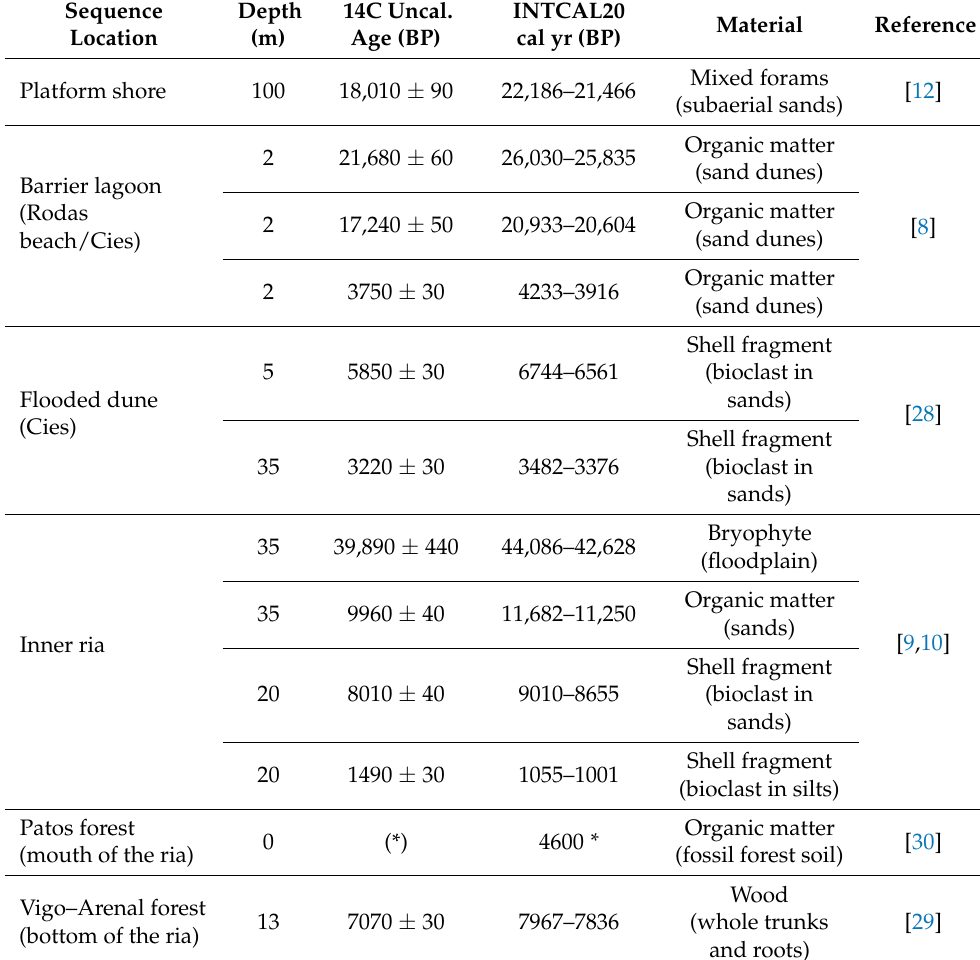
Table 1. Conventional 14 C ages from sedimentary deposits related to flooded aeolian sands in the Cies Islands and Ria de Vigo. All these data have been recalibrated in this paper using the INTCAL20 curve [32] from the on-line OxCall program (v4.4), except for the calibrated age of the Patos forest (*) from [30]. The table specifies the dated material and the type of sediment in which it was found. Depth 14C